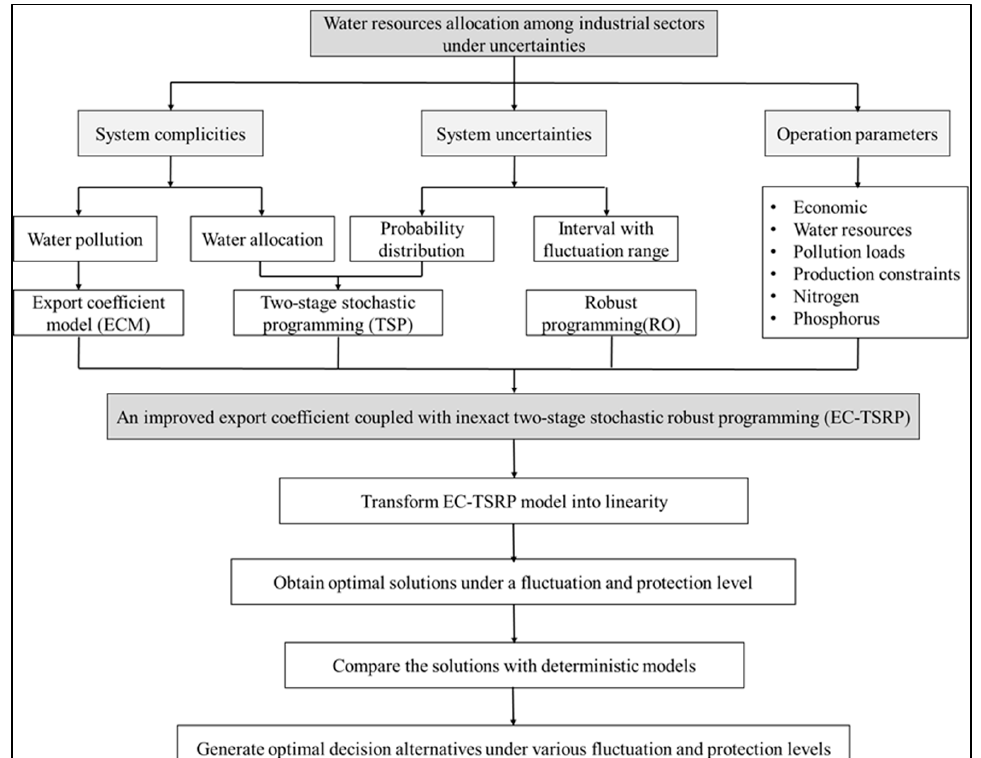
Figure 1. Schematic diagram of the EC-TSRP method.